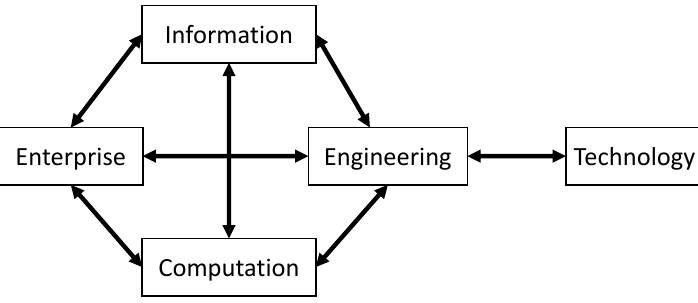
Figure 2. Relationships among the Reference Model for Open Distributed Processing (RM-ODP) viewpoints according to